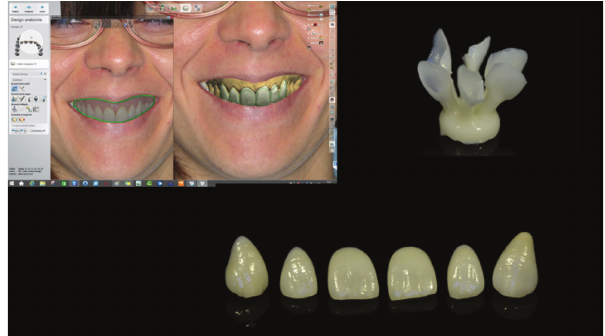
Figure 7: Case 2 (Bilayered Lithium Disilicate Veneer Replace- ment). The new smile design was cut away and inserted in the patient’s physiognomic image. After designing the new veneers, they were pressed with lithium disilicate (IPS e.max Press MT) and